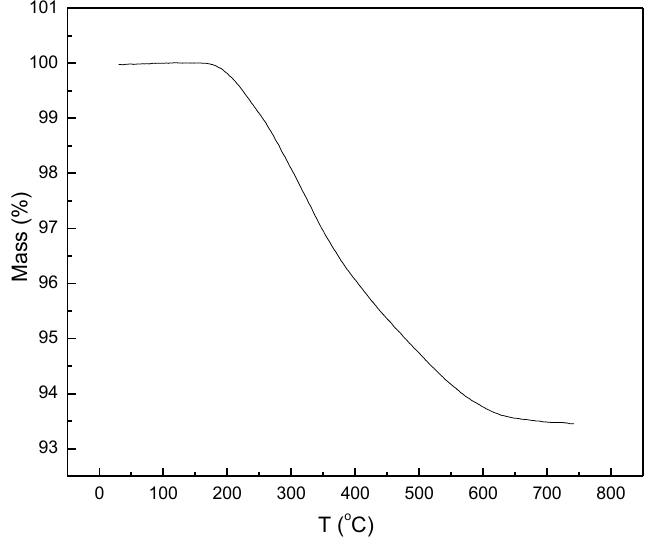
Figure 3. Thermogravimetric measurement of mass loss during deuterium desorption from Ti 0.63 V 0.27 Fe 0.10 D 1.73.